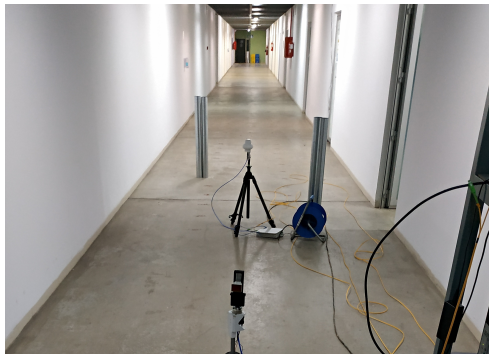
Figure 1. File photo of the corridor.